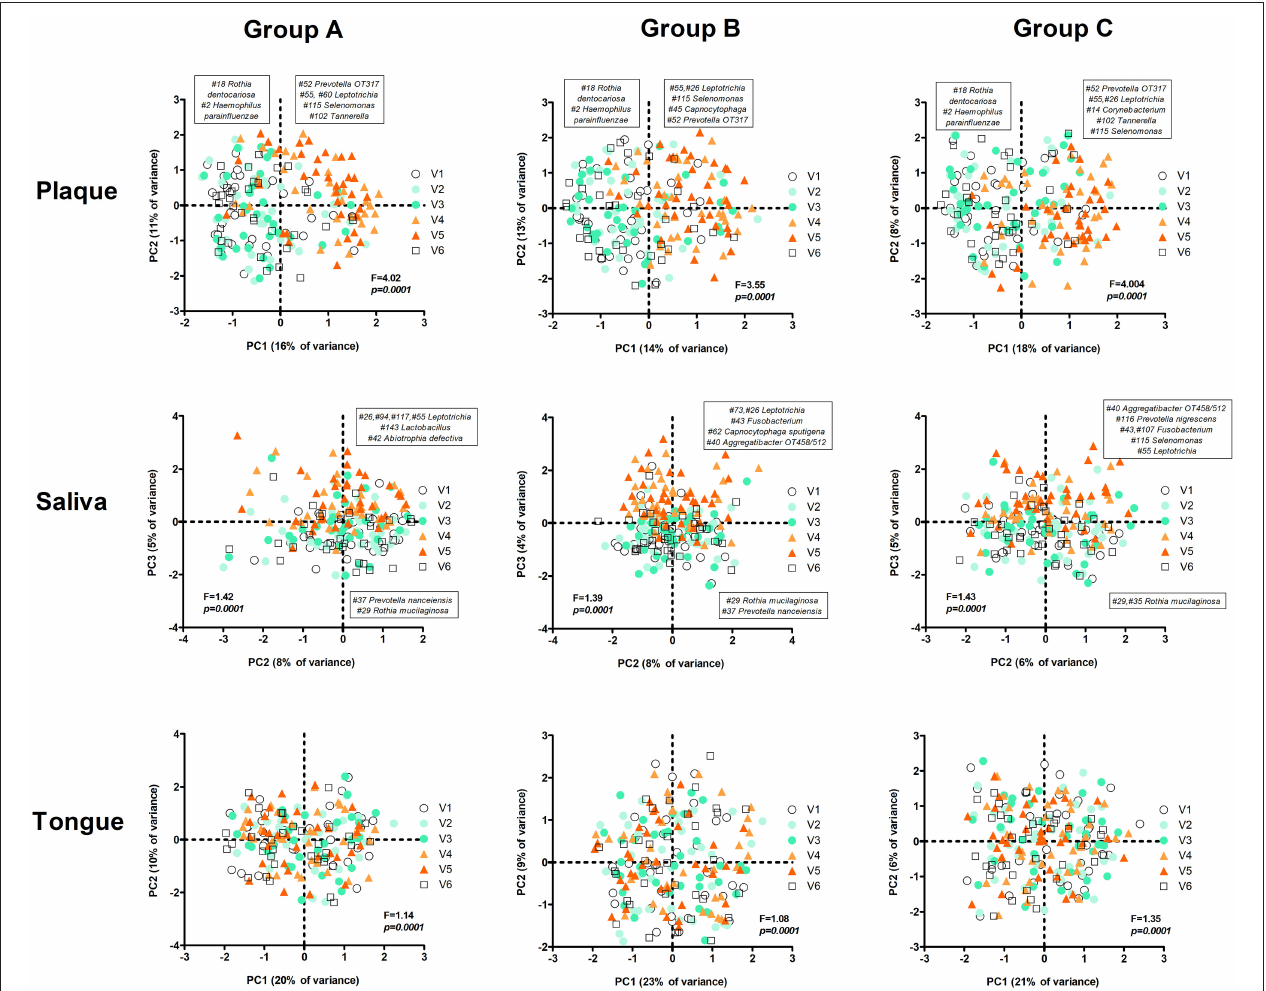
FIGURE 9 | PCA plots per group and sample type by visit. The text boxes indicate the zOTUs that were the main loadings (arbitrary threshold 0.1/ − 0.1) of the principal components that were associated with experimental gingivitis (V4 and V5): PC1 (left – negative loadings, right – positive loadings) in plaque and PC3 in saliva samples (upper half of het plot – positive loadings, the lower part of the plot – negative loadings). No specific component associated with V4 and V5 was identified for the tongue samples. F and p -value – restricted PERMANOVA.